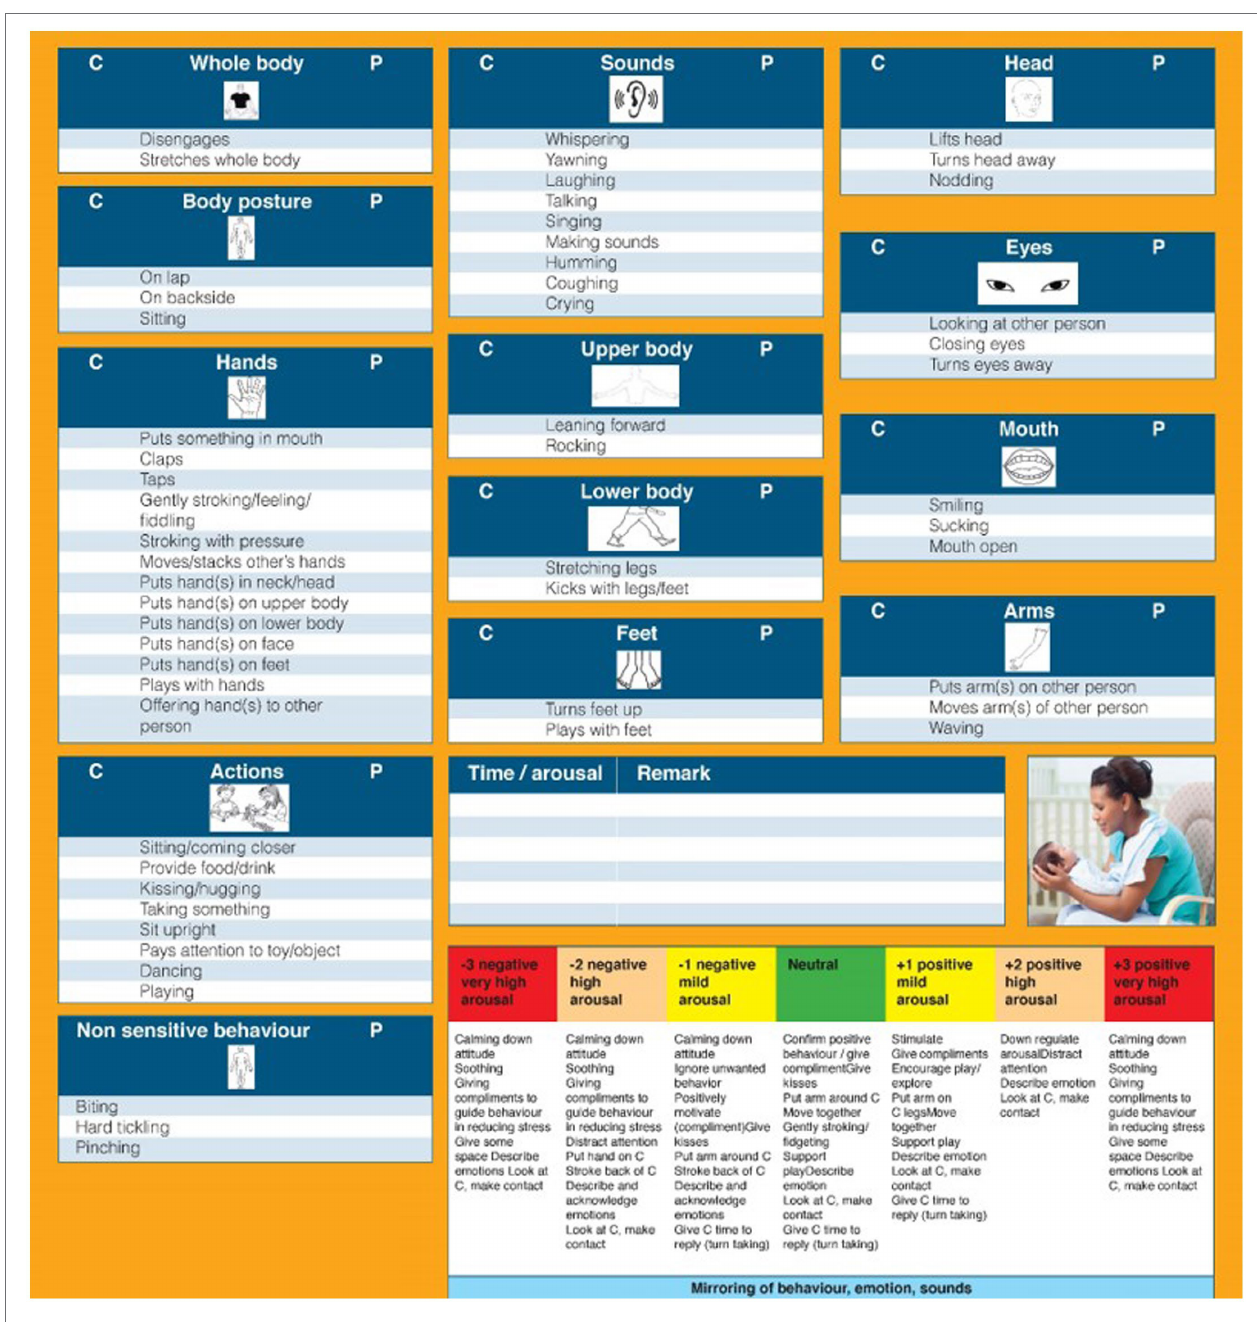
FIGURE 1 | The attune & stimulate mother-infant